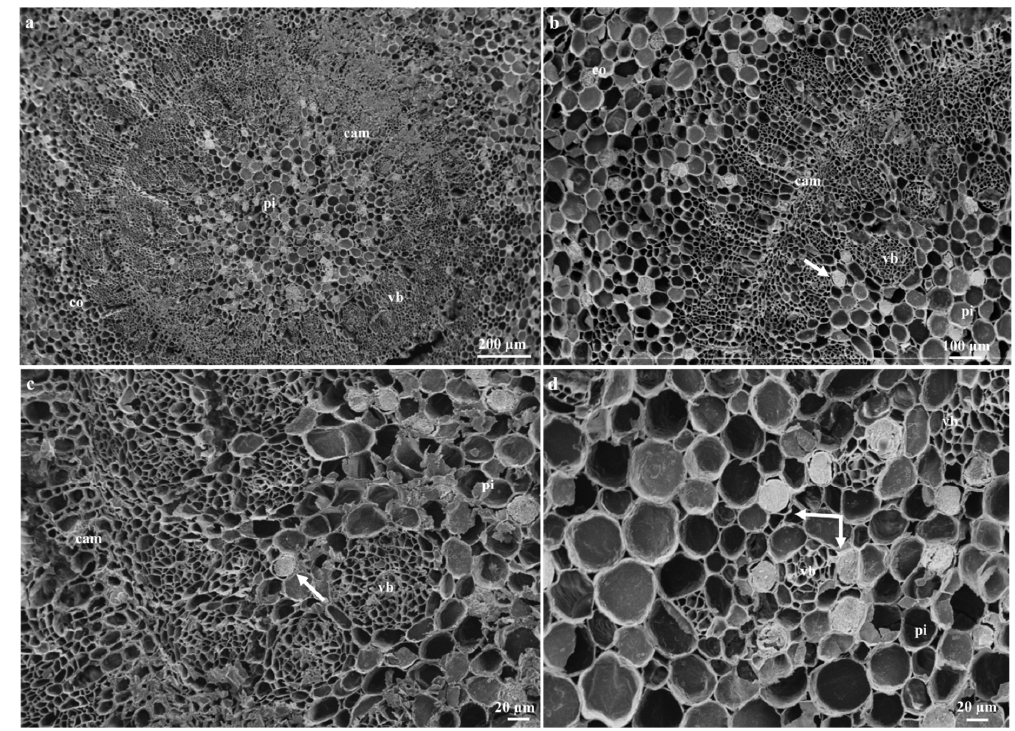
Figure 6. Scanning electron microscopy micrographs showing freeze-fractures of adult stems of T. ventricosa. ( a ) Low-magnification SEM micrograph showing the distribution of laticifers in a freeze-fracture of a young stem. ( b ) Freeze-fracture of a young stem depicts the arrangement of laticiferous cells along the vascular cambium. ( c ) Laticifer cell distribution among vascular bundles of a young stem. ( d ) High-magnification image showing appearance of laticifer and latex exudate from a young stem. Abbreviations vb = vascular bundles, cam = cambium, co = cortex, pi = pith. Arrows refer to laticifer.